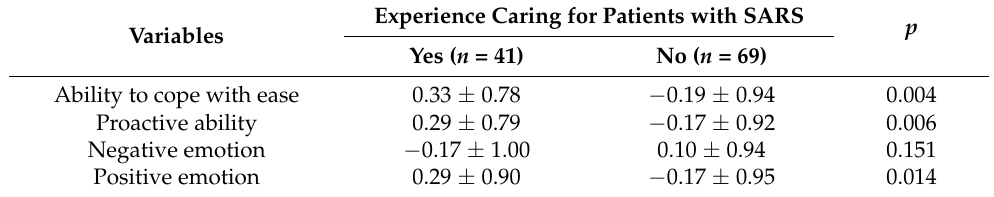
Table 4. Measurement of the self-efficacy and emotional traits of subjects with or without the experience of caring for patients with SARS in coping with the COVID-19 pandemic. The results were expressed as mean ± standard deviation (SD).